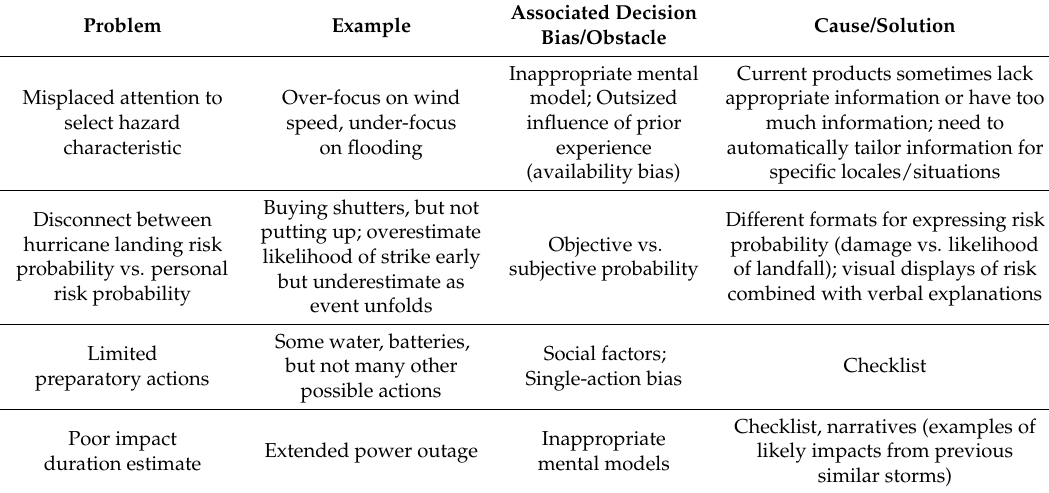
Table 3. Decision biases and solutions during forecast